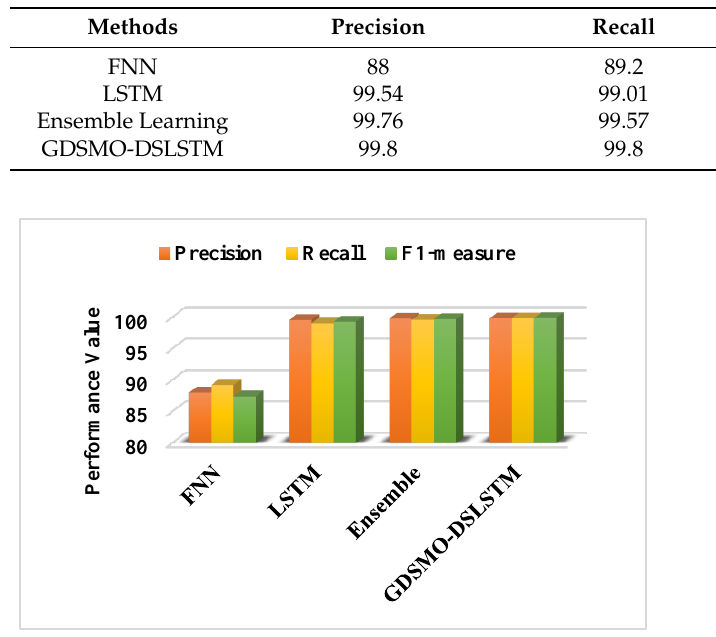
Figure 21. Comparative analysis based on precision, recall, and f1-measure. Table 8. Precision, recall and f1-measure of existing and proposed classification techniques.